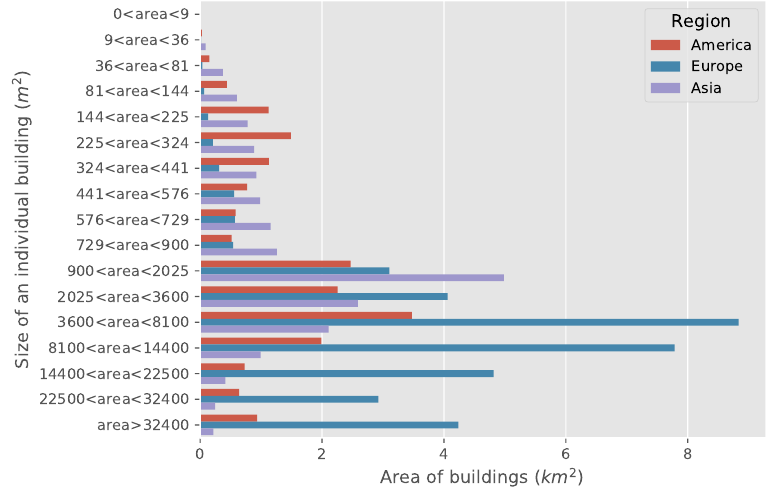
Figure 12. Distributions of building size for the DREAM-B data set.